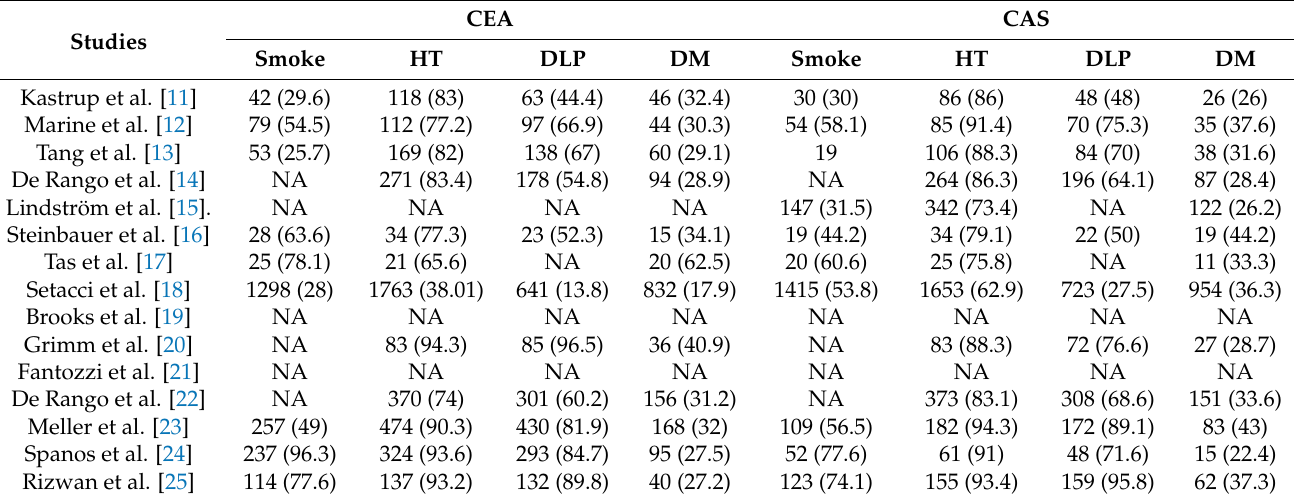
Table 2. Patients’ comorbidities in each group.